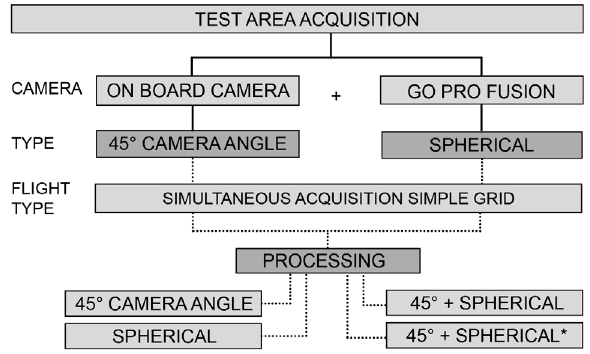
Figure 4. Test area dataset acquisition and processing workflow. *Marking GCPs on frame images only